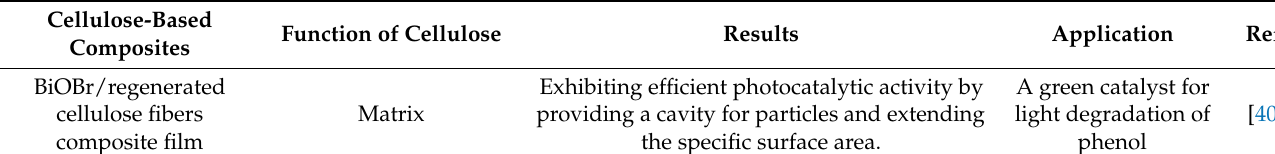
Table 2. The effects and applications of cellulose fibers and their